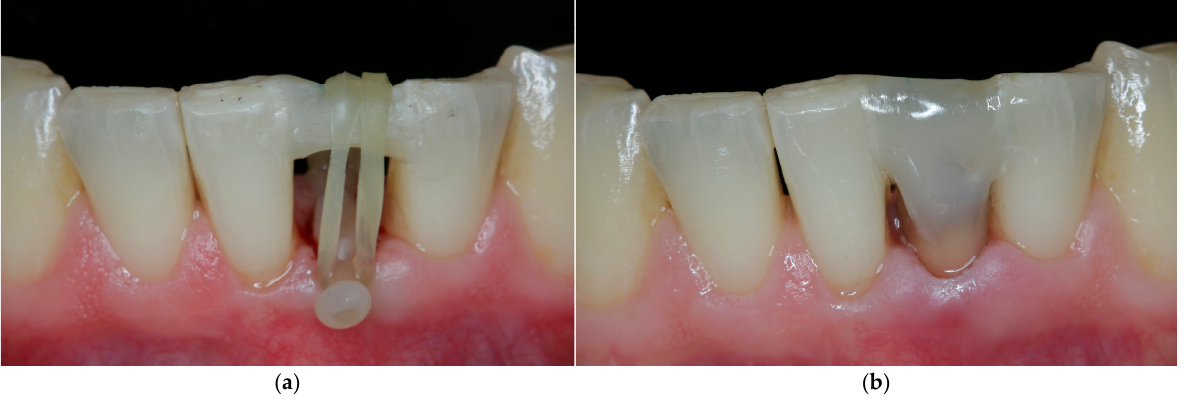
Figure 6. Forced orthodontic extrusion. ( a ) Construction of the orthodontic appliance: elastics initi ‐ ate tooth movement in occlusal direction. ( b ) After extrusion, tooth is splinted to adjacent teeth for retention.